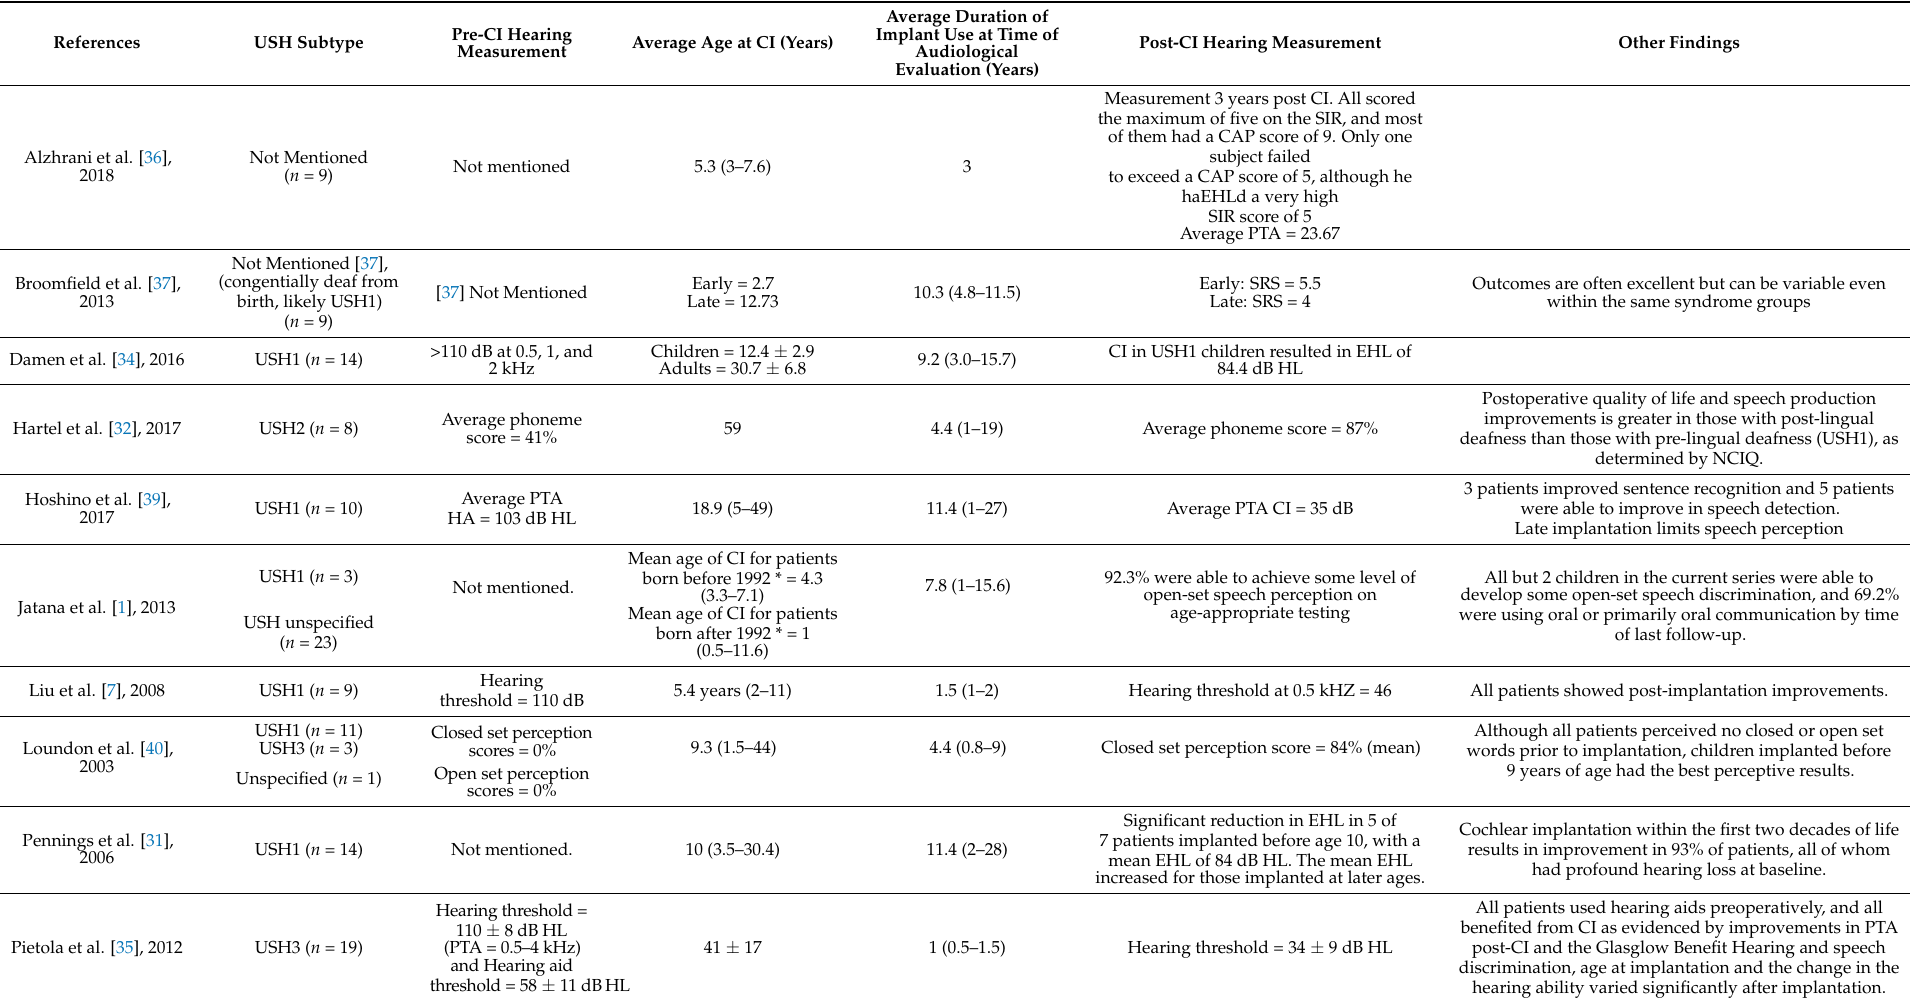
Table 3. Summary of findings from multi-patient